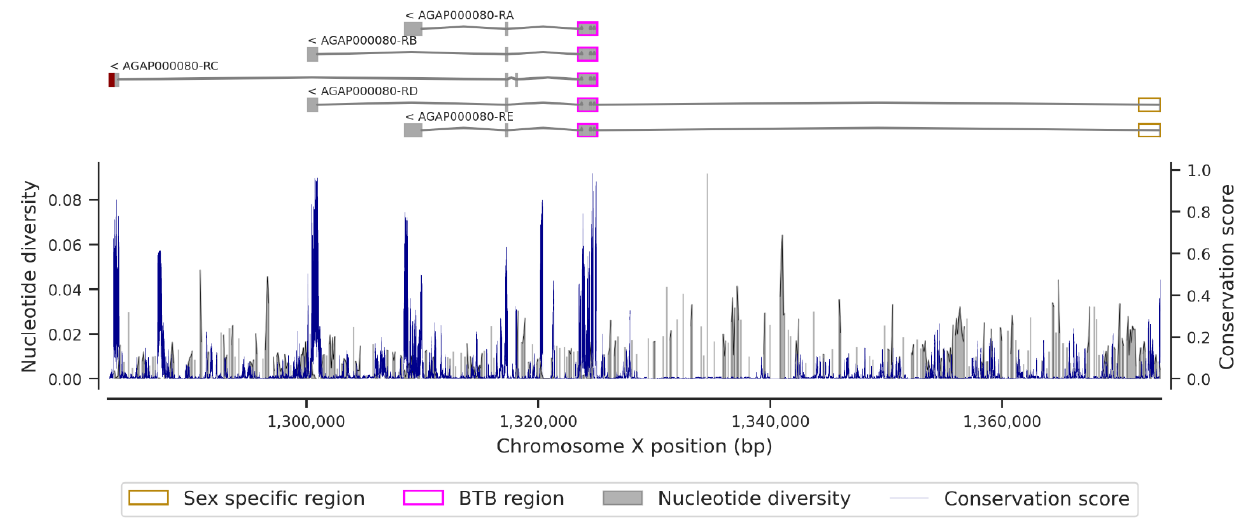
Figure 4. Conservation score and nucleotide diversity in a window of 12 bp within the sex-specific region of the Fruitless gene. The upper figure shows the five transcripts of the Fruitless gene (rectangles correspond to the exonic regions, simple lines are the intronic regions, and dark-red end is the 3 prime UTR within the AGP000080-RC transcript); lower figure shows the conservation score (blue line) and the nucleotide diversity (dark fill) plot.